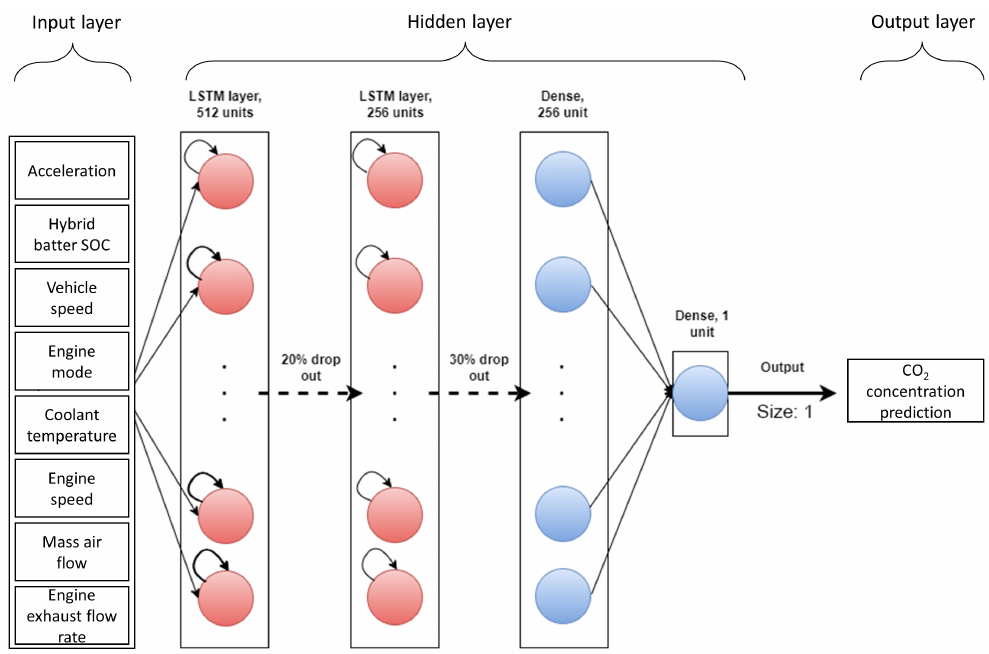
Figure 5. Architecture of proposed LSTM-based algorithm.